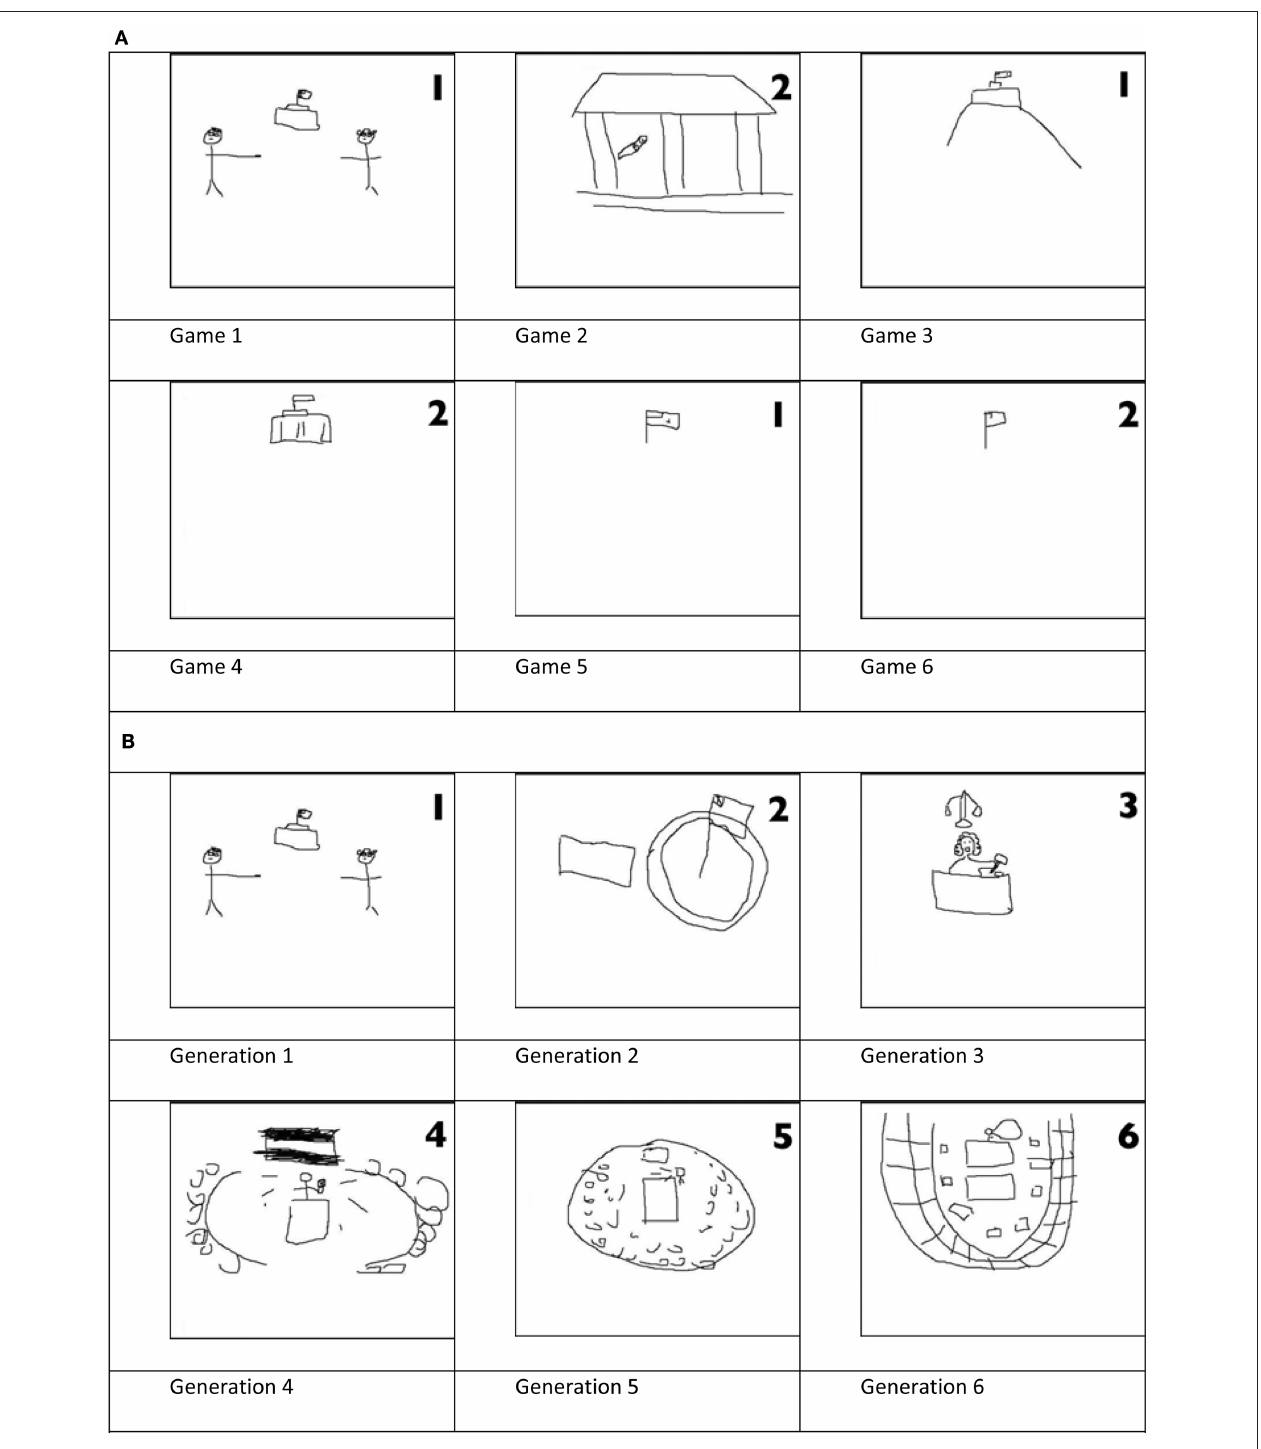
Figure 8 | Drawing refinement and convergence for the concept “Parliament” (A) across six games between an interacting pair and (B) across six generations in a diffusion chain. Participant numbers are given in bold on the top right of each drawing. (From Garrod et al., 2010).